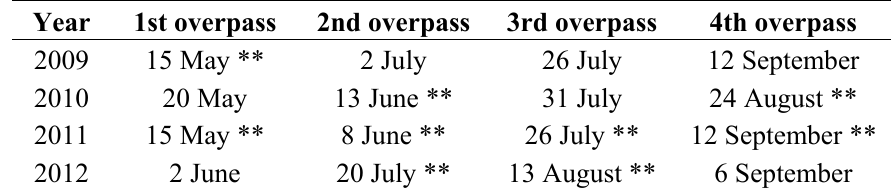
Table 2. Overpass dates for Radarsat-2 synthetic aperture radar (SAR) imagery. Data for 2009 were acquired with Fine Quad Beam 12 (FQ12) *; data for all other years were acquired with FQ2